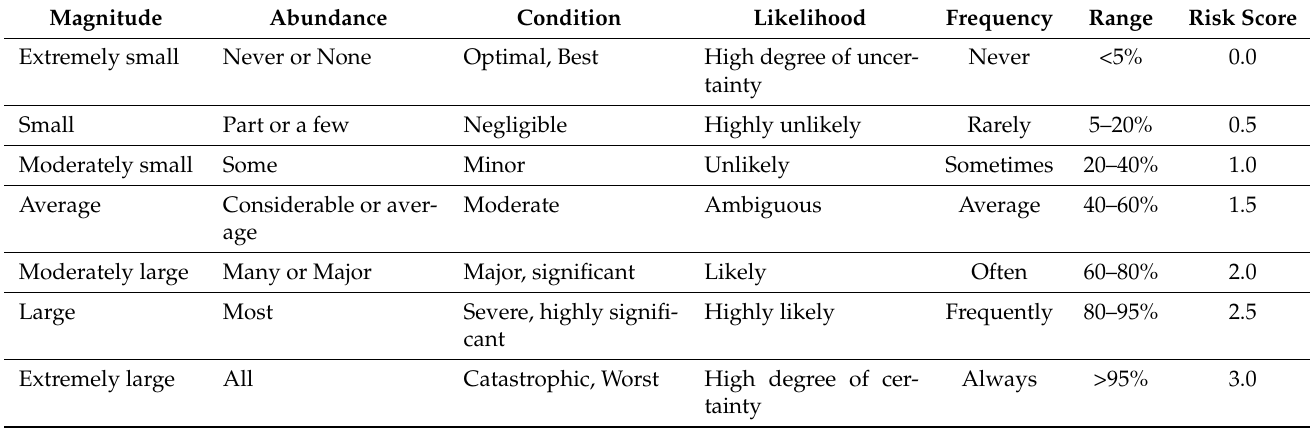
Table 2. Criteria of the risk states of the tier 2 ecosystem-based fisheries assessment (employed from the existing EBFA [10]). Magnitude Abundance Condition Likelihood Frequency Range Risk Score Extremely small Never or None Optimal, Best High degree of uncer- Never <5% 0.0 tainty